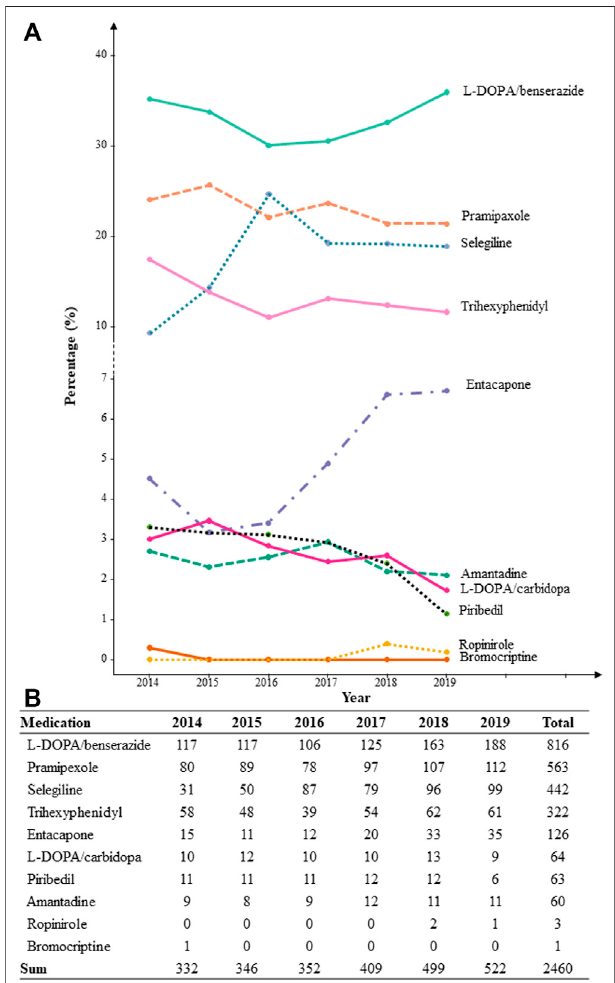
FIGURE 1 | The percentage (A) and count (B) of patients with each prescribed anti-Parkinson ’ s disease drug from 2014 to 2019 based on each